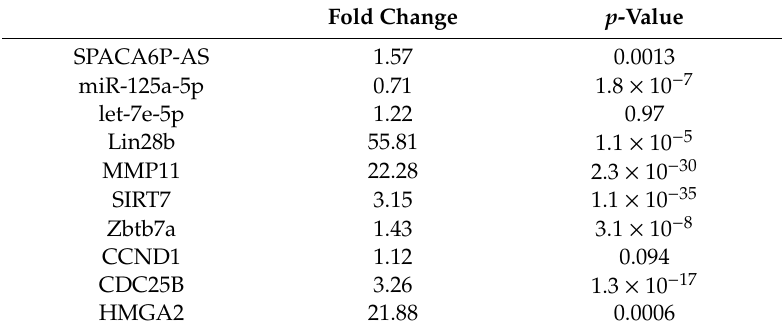
Table 1. Gene expression changes in 374 HCC tissues compared to 50 normal liver samples (data from Encori,